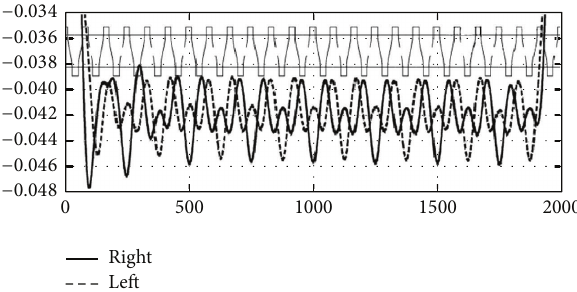
Figure 14: Vertical displacements of the vehicle/track contact points at the speed 50 m/s [11,